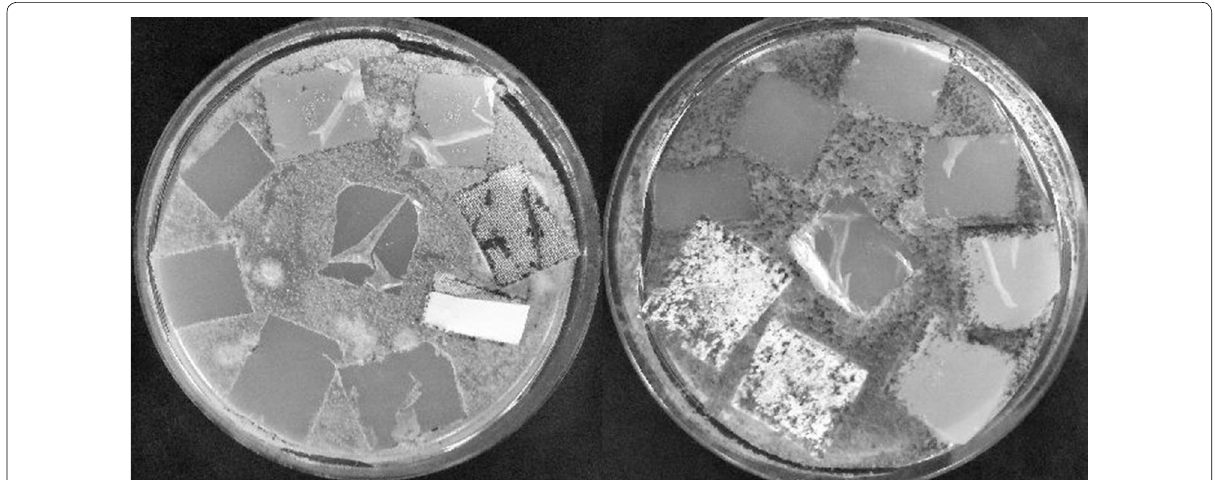
Fig. 3 Agar plate test for